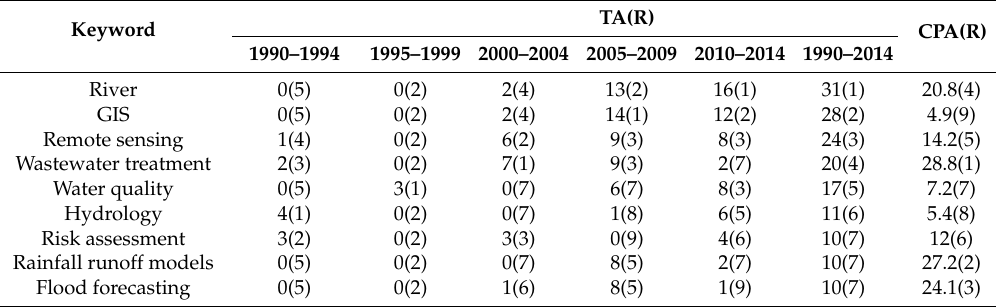
Table 8. Most frequently used keywords in